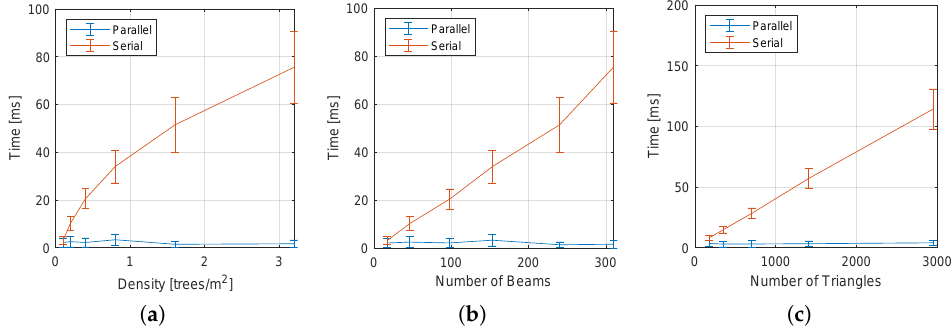
Figure 14. Effect of the lattice parameters and environment density on the tree pruning time for both the serial and parallel implementation of the method. ( a ) Effect of the density of the forest; ( b ) effect of the number of laser beams; ( c ) effect of the number of triangles.